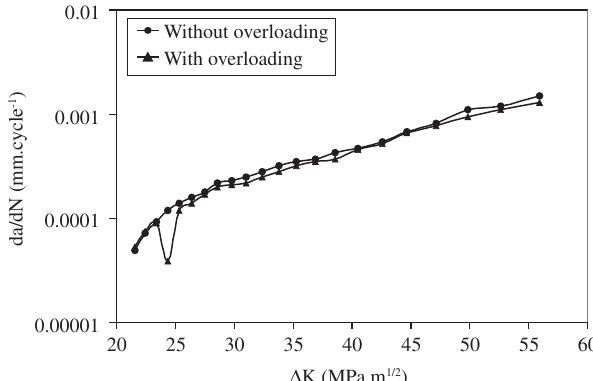
Figure 3. da/dN vs. ∆ K for WH microstructural condition after an overload of 13.5 kN.